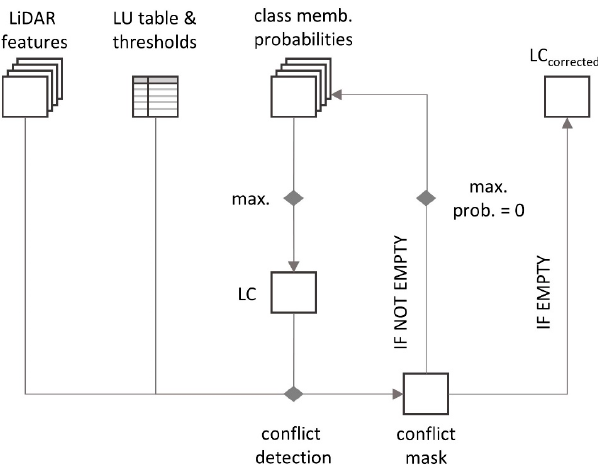
Figure 6. Detailed workflow of the iterative LiDAR post-classification correction used in this research.